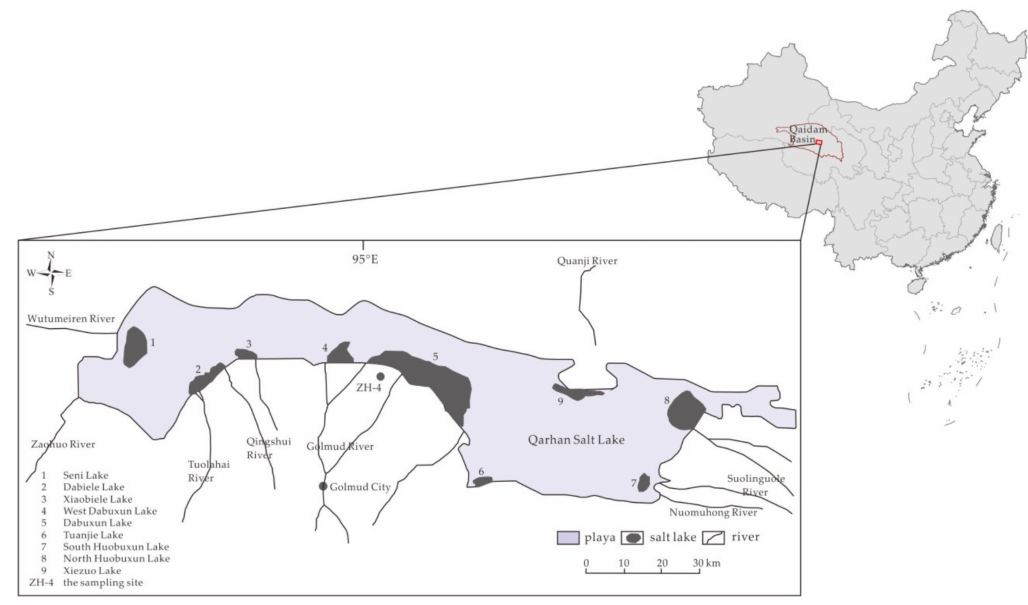
Figure 1. Location of the sampling site (modified from Du et al.